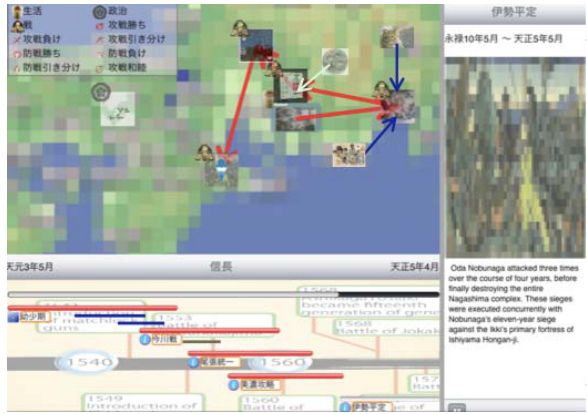
Figure 2. An example of a path of traversing a hierarchy of different detailed timelines. The path becomes a script code of an animation of historical storytelling.